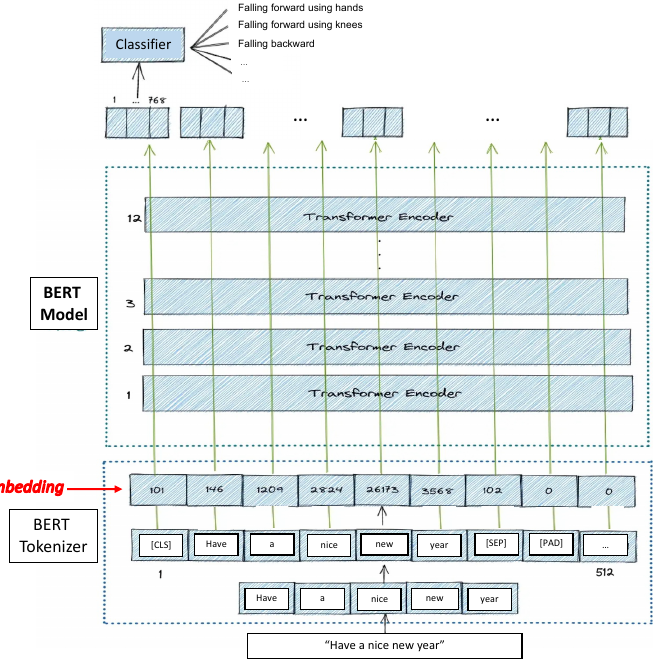
Figure 2. Illustration of the input and output of the BERT